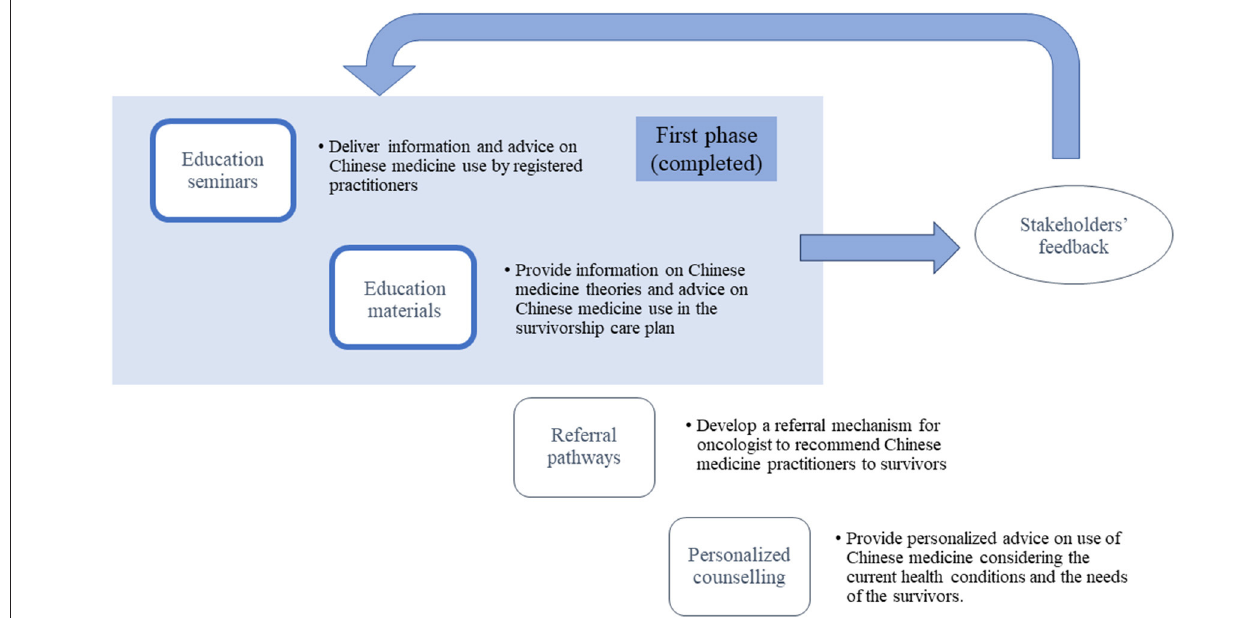
FIGURE 1 | The framework of the educational program.